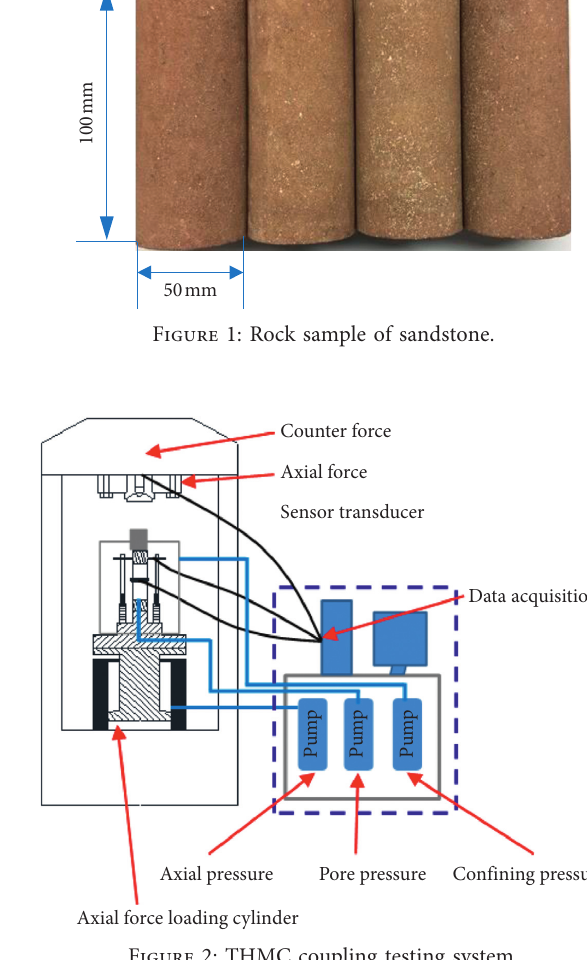
Figure 2: THMC coupling testing